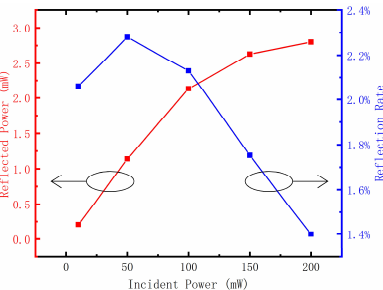
Figure 7. The reflected power and reflection ratio at different incident excitation power of another green light emitting diodes (LED) sample pumped with the same laser which demonstrates the dependence of excitation power and reflection ratio.